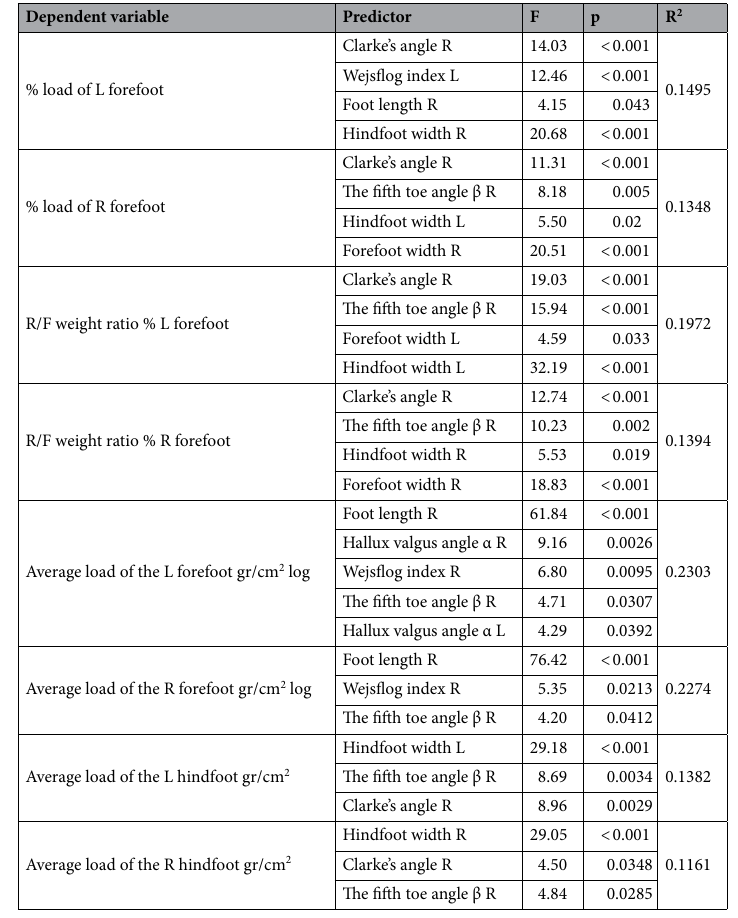
Table 5. Stepwise regression models in the group of girls. F—value of the Fisher-Snedecor test statistics, R 2 — coefficient of determination, log- logarithm of the variable under